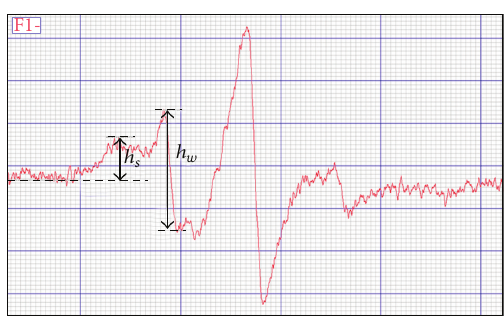
Figure2:ESRspectrumoferythrocyteslabeledwith12-doxylstearic acid. Measurement parameters: center field: 3473 G, frequency: 9.74 GHz, microwave power: 10 mW, and sweep width: 100 G.